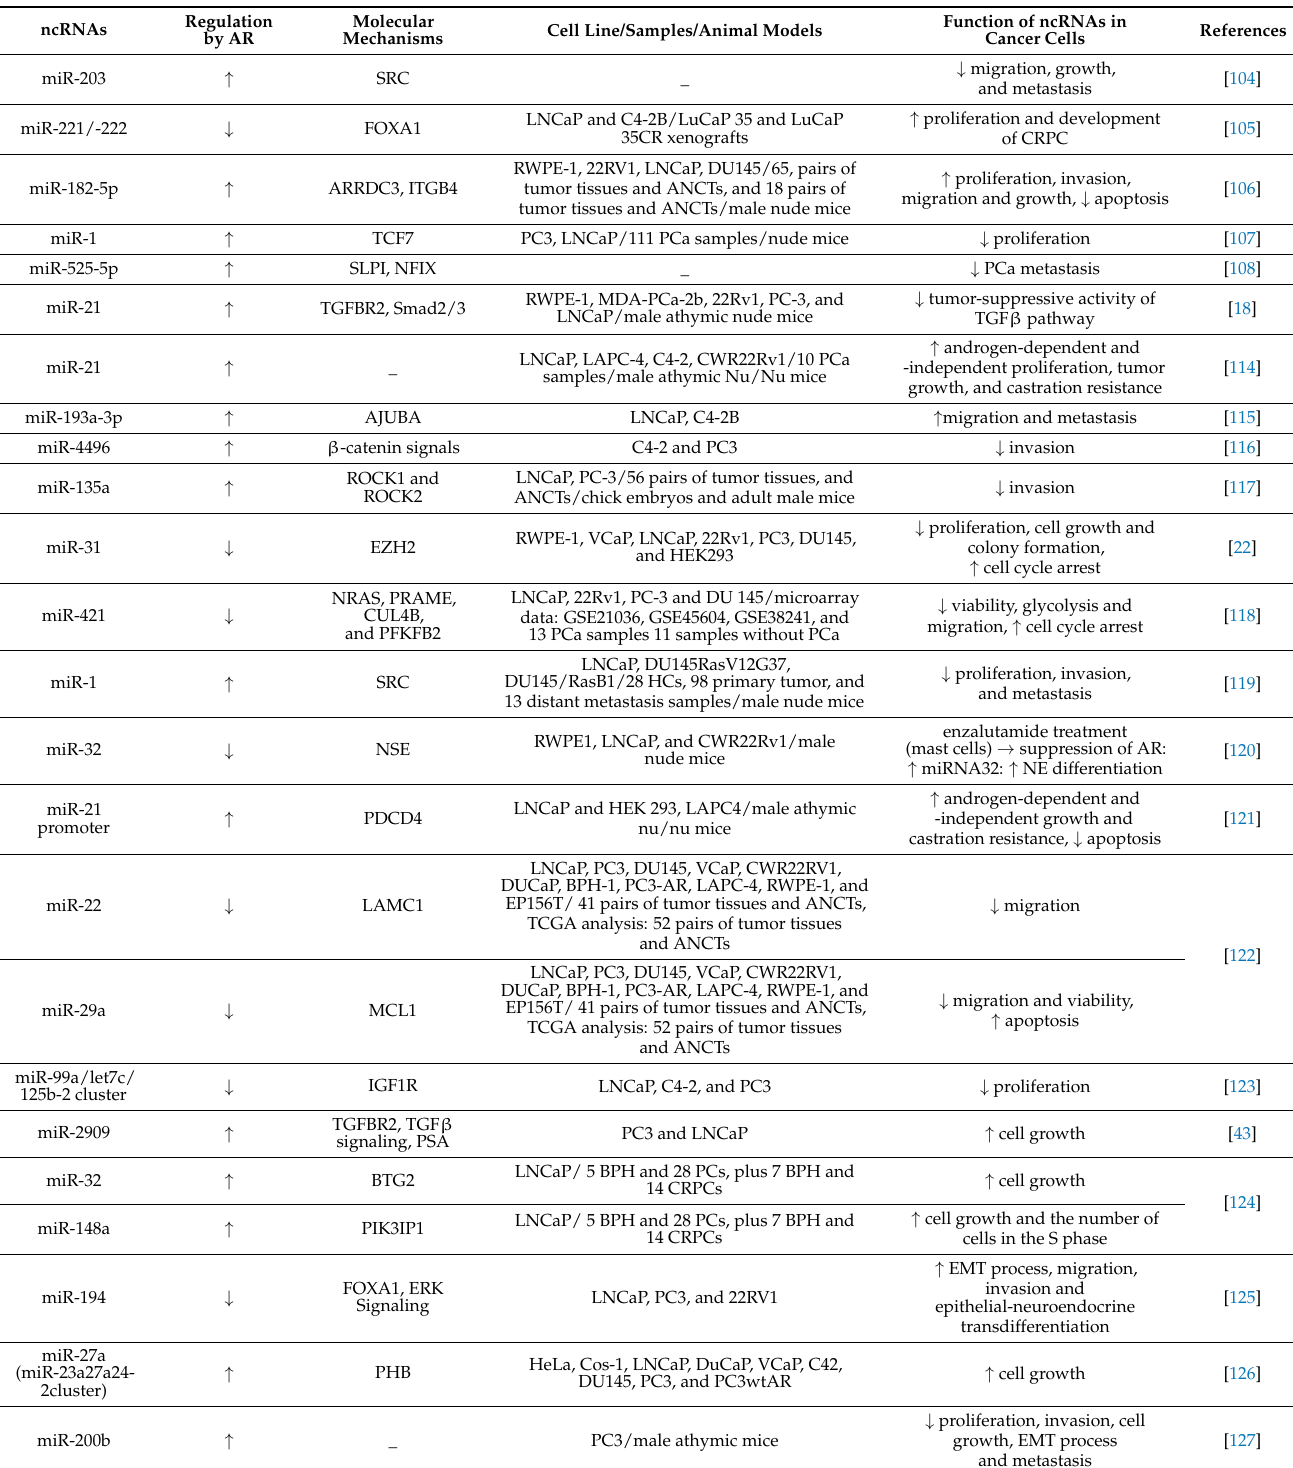
Table 6. Effects of AR on different ncRNAs in prostate cancer. (PCa: prostate cancer, CRPC: castration-resistant prostate cancer, HCs: healthy controls, NE: neuroendocrine, BPH: benign prostatic hyperplasia, CRPC: castration-resistant prostate cancer, DOX: doxorubicin, NED: neuroendocrine differentiation, NE: neuroendocrine, Enz: enzalutamide, PRAD: prostate adenocarcinoma, R-2HG: R-2-hydroxyglutarate, ↓ : decrease in, ↑ : increase in).